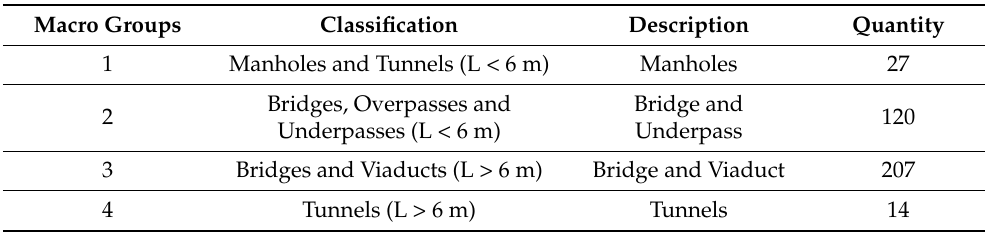
Table 1. Summary of classification, description, and quantity of the A3 highway assets for each macro